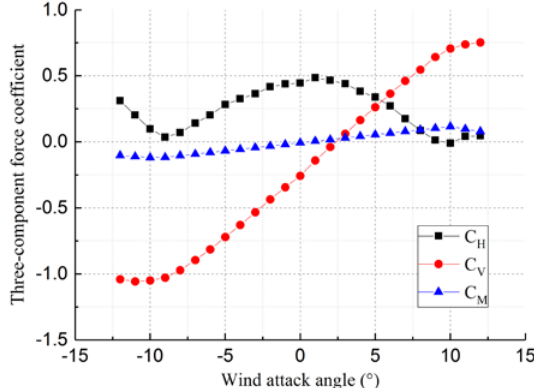
Figure 13. Three-component force coefficient curve of main beam in construction state.